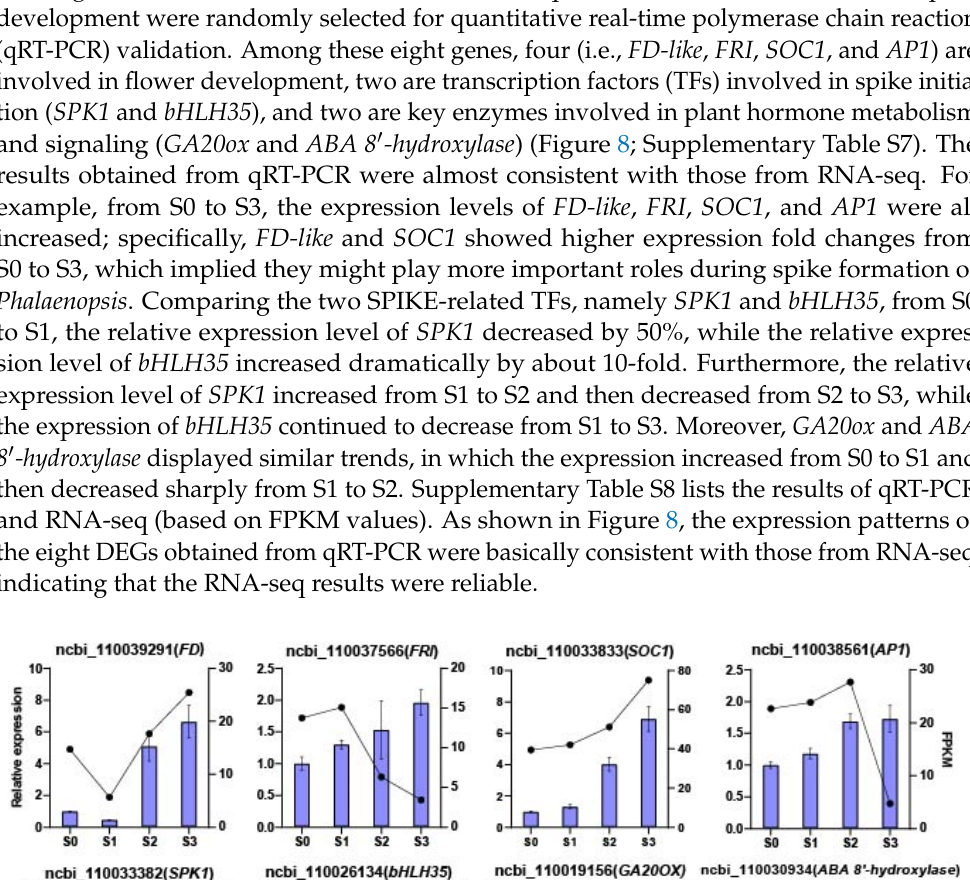
Figure 7. Heatmaps of differentially expressed genes (DEGs) related to plant hormone metabolism and signaling at the four statuses of spike formation of Phalaenopsis . From top to bottom, the five panels show DEGs involved in the GAs’, ABA’s, SA’s, auxin’s, and CTKs’ biosynthesis, metabolism, and signal transduction pathways, respectively. Red squares indicate upregulation, whereas blue squares indicate downregulation. The color scale corresponds to the average log 10 (FPKM+1) and Z-score (normalized by the R software) values. GA, gibberellic acid; ABA, abscisic acid; SA, salicylic acid; CTK, cytokinin; FPKM, fragments per kilobase of transcript per million mapped reads.